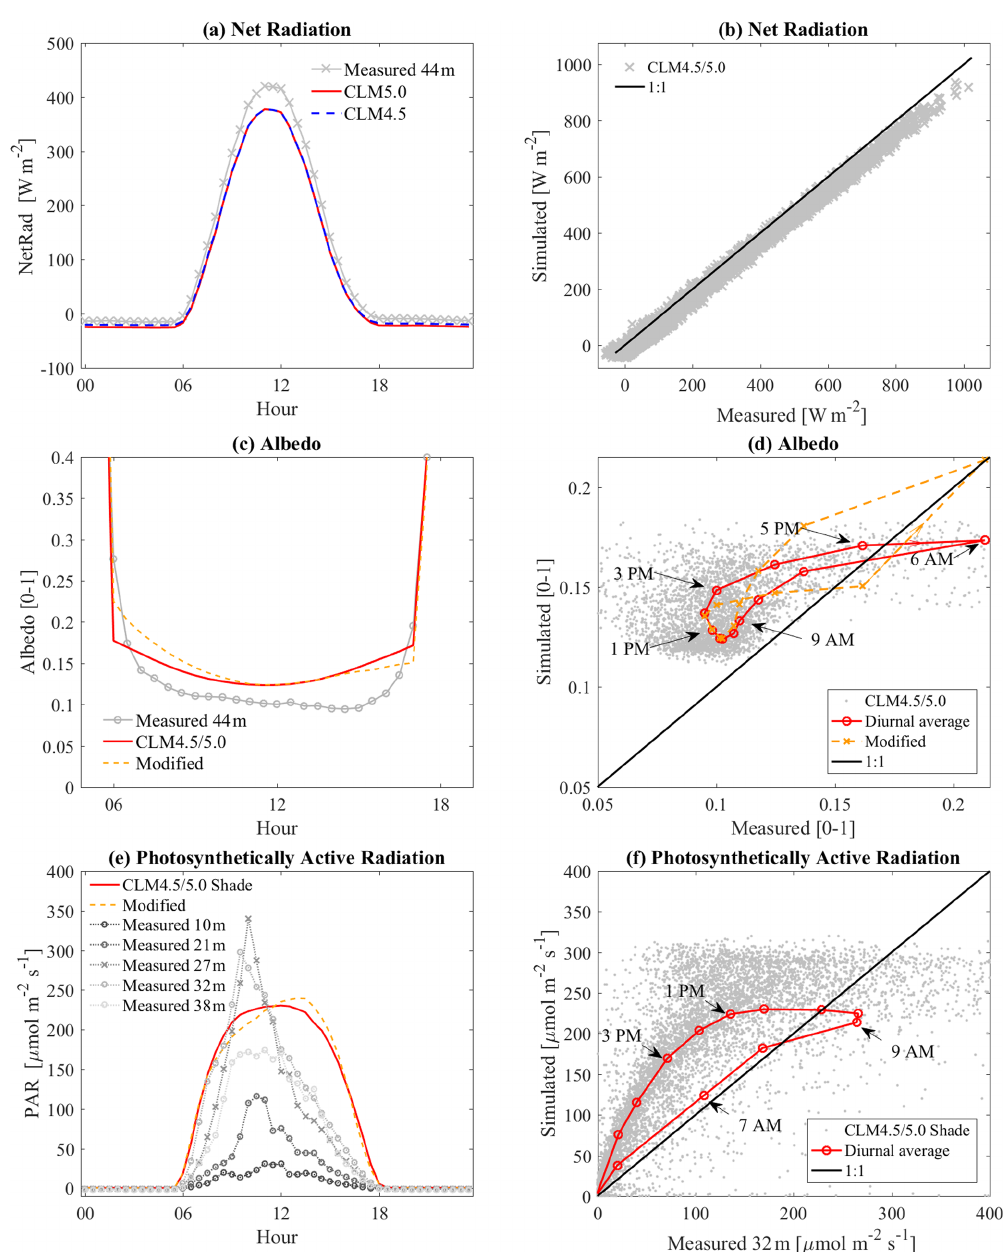
Figure 4. (a, b) Comparison of net radiation between CLM and measurements on the canopy tower at 44m. (c, d) albedo at 44m. (e, f) PAR comparison for shaded canopies. All left plots (a, c, e) are ensemble diurnal variation, and the right plots (b, d, f) are one-to-one comparison plots between CLM and measured data. Hysteresis depicted in (d) and (f) is based on hourly ensemble average values for daytime. “Modified” is an attempt to mimic the slope effect with a simple update of the two-stream